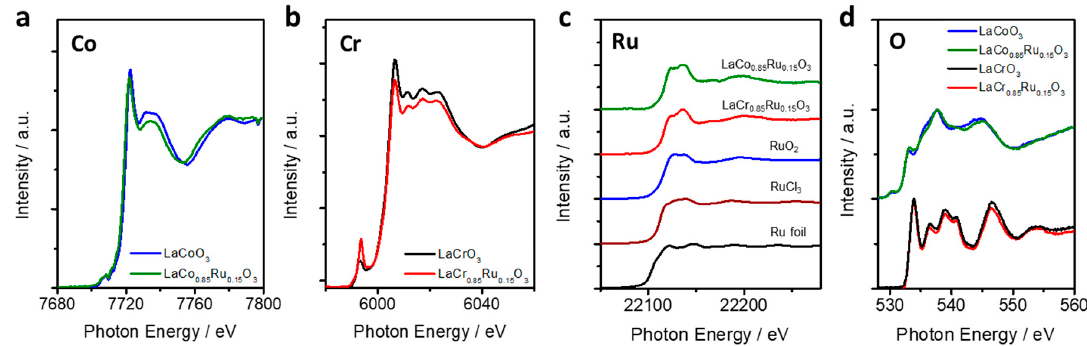
Figure 4. XAS analysis of the normalized XANES spectra of ( a ) Co K-edge (LaCoO 3 and LaCo 0.85 Ru 0.15 O 3 ), ( b ) Cr K-edge (LaCrO 3 and LaCr 0.85 Ru 0.15 O 3 ), ( c ) Ru K-edge (LaCo 0.85 Ru 0.15 O 3 and LaCr 0.85 Ru 0.15 O 3 including RuO 2 , RuCl 3 , Ru foil as references) and ( d ) O K-edge (LaCoO 3 , LaCo 0.85 Ru 0.15 O 3 , LaCrO 3 and LaCr 0.85 Ru 0.15 O 3 ). From Figure 4c, the normalized Ru K-edge XANES spectra of LaCo 0.85 Ru 0.15 O 3 and